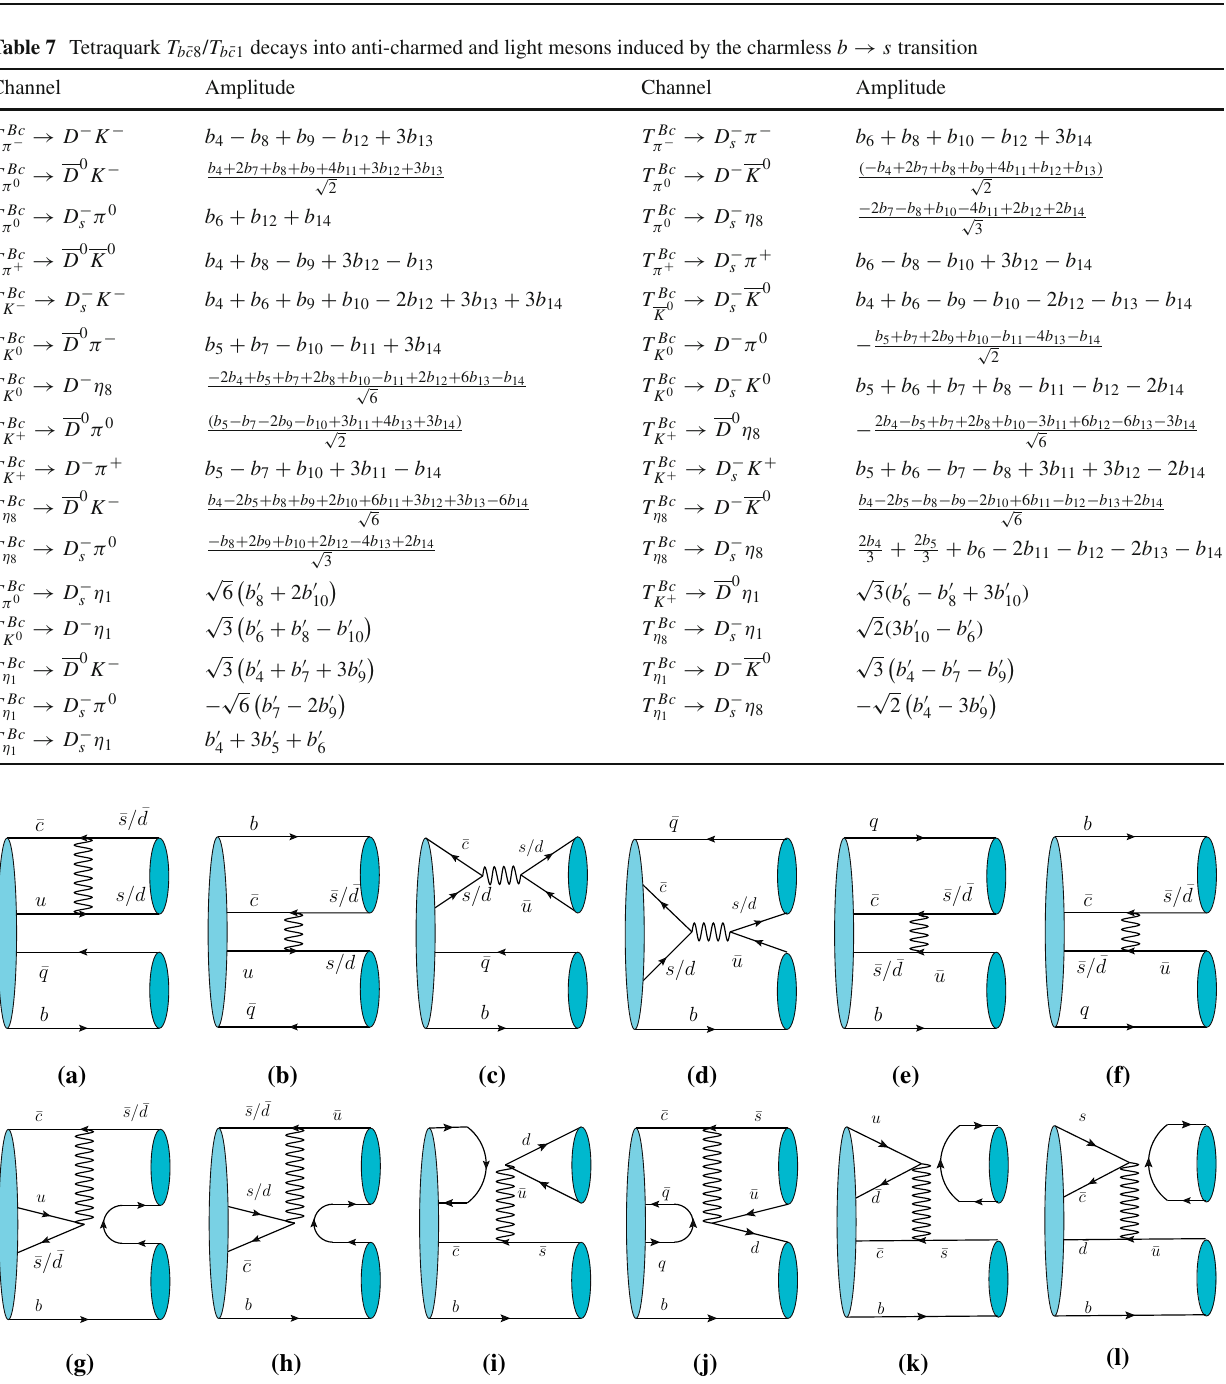
Fig. 3 Topological diagrams for the ¯ c -quark non-leptonic decays of tetraquark T b ¯ c 8 / T b ¯ c 1 . The two-body processes are given in a – l . The ¯ c -quark decays have the similar structures with the b -quark decays. The a – l contribute to the process of T b ¯ c 8 / T b ¯ c 1 decays into B plus a light